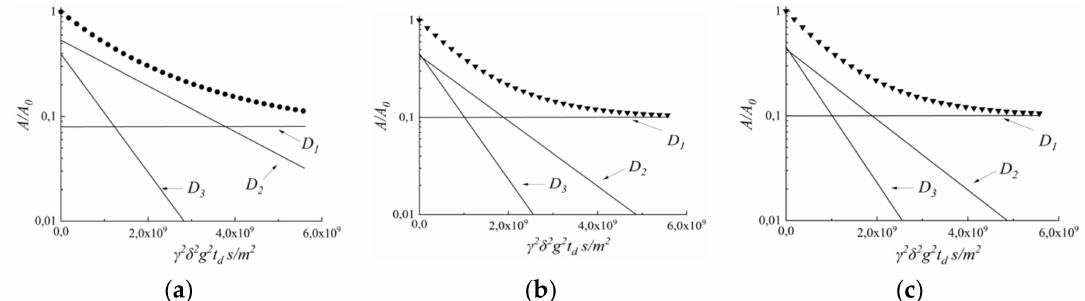
Figure 2. Spin echo attenuation (di ff usion decay) of water molecule 1 H nuclei in Li + ionic form ( a ), Na + ionic form ( b ) and Cs + ionic form ( c ) of MSC membrane; RH = 95%, T = 293K. Dots are experimental curves; straight lines are decomposition on D 1 , D 2 , D 3 components from Equation (4). Components of di ff usion coe ffi cients D 1 , D 2 , and D 3 and relative parts p 1 , p 2 , and p 3 are the next. For Li + ionic form, MSC D 1 = (2.4 ± 0.5) 10 − 13 m 2 / s, D 2 = (5.0 ± 0.5) · 10 − 10 m 2 / s, D 3 = (1.3 ± 0.5) · 10 − 9 m 2 / s and (0.08 ± 0.01), (0.53 ± 0.05), (0.39 ± 0.05), correspondingly. For Na + ionic form, MSC (4.5 ± 0.5) · 10 − 13 m 2 /